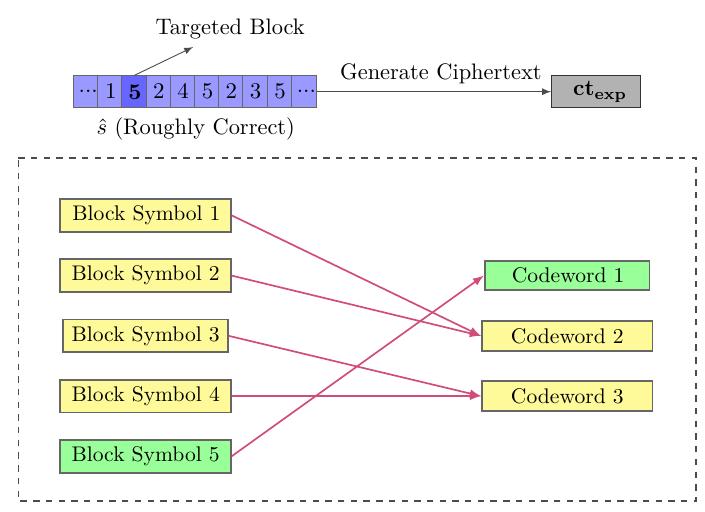
Figure 2: The expected coding for ct exp